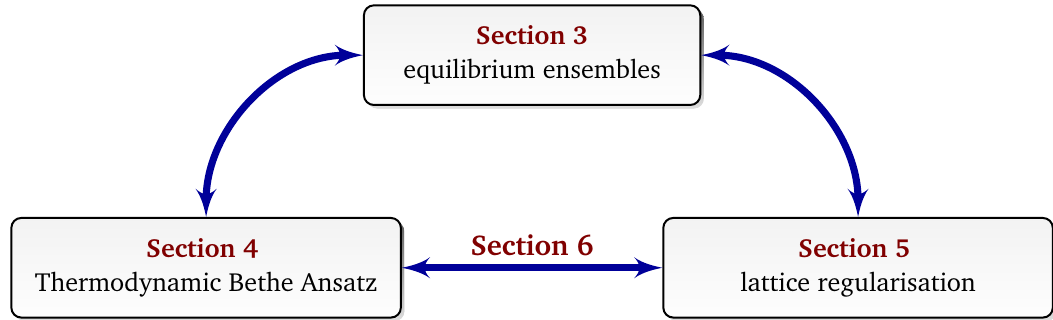
Figure 1: Outline of the paper. In Section 2 we introduce the Heisenberg spin-1 / 2 chain and define the main objects of the integrability framework. In Section 3 we discuss generic equilibrium ensembles and specify the general density matrix. In Section 4 we cover the TBA approach and systematically discuss analytic properties of generic macrostates. In Section 5 we regularise the general density matrix and recast it as a two-dimensional classical vertex model. In Section 6 we define the mirror system and employ functional Bethe ansatz to demonstrate equivalence with